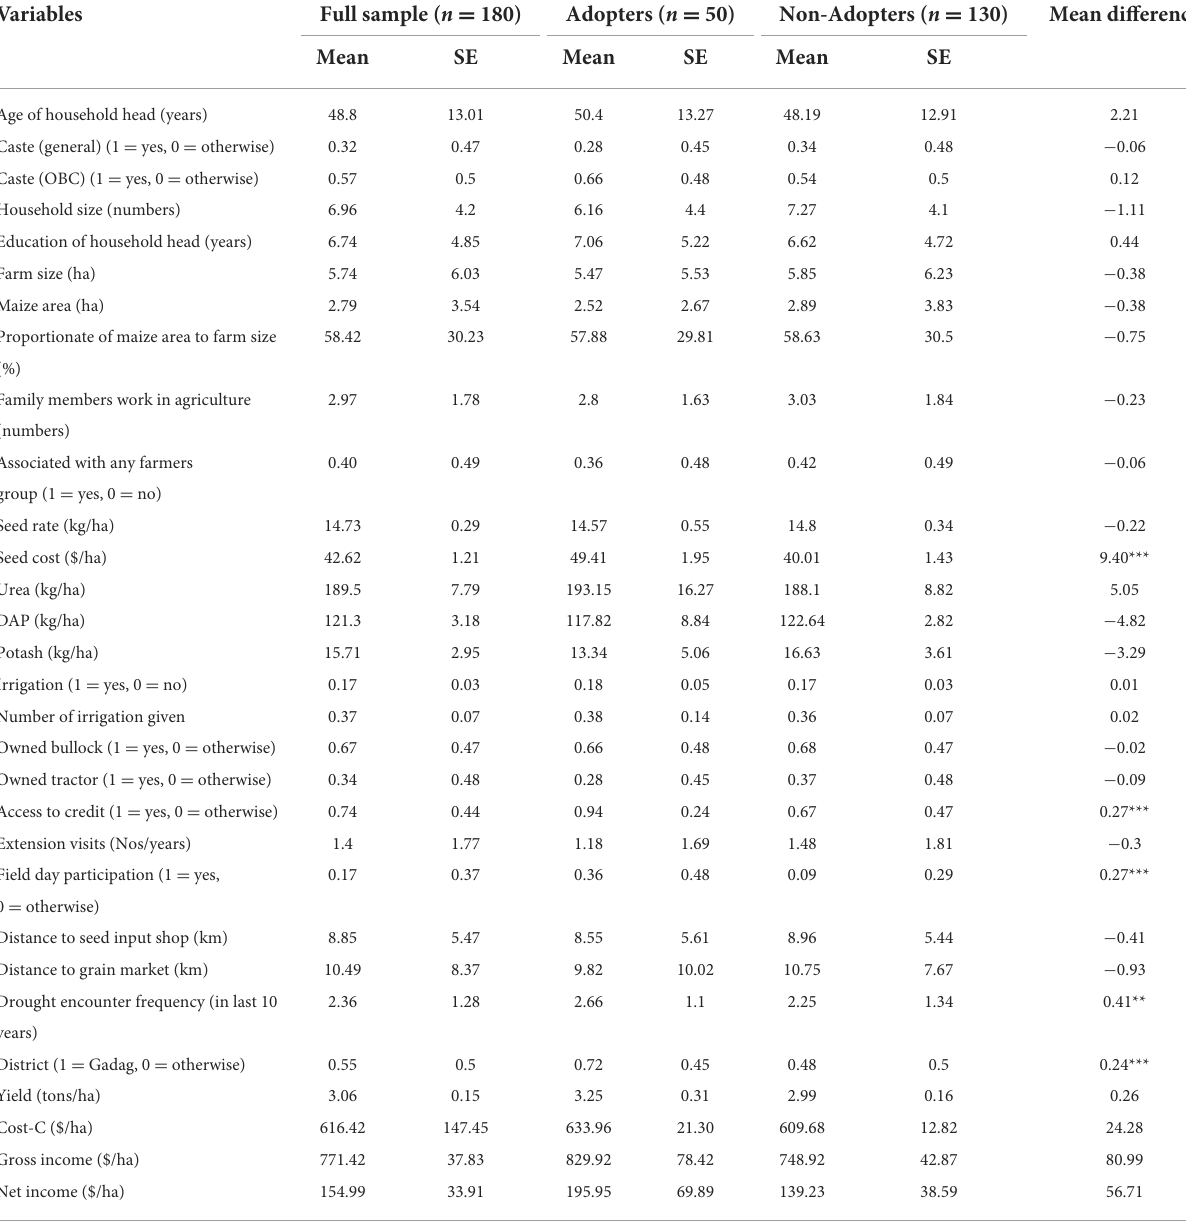
TABLE 1 Social and economic status of sampled